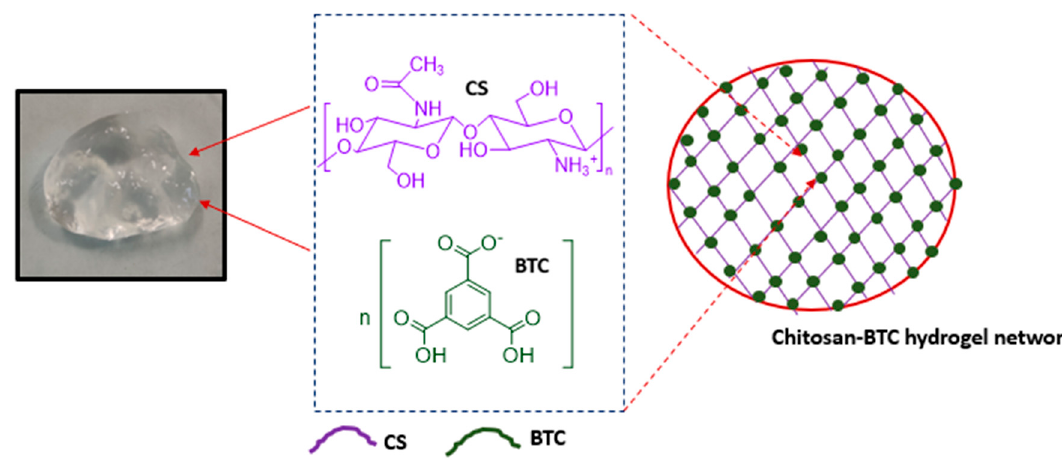
Figure 3. Chitosan–BTC hydrogel (M1).